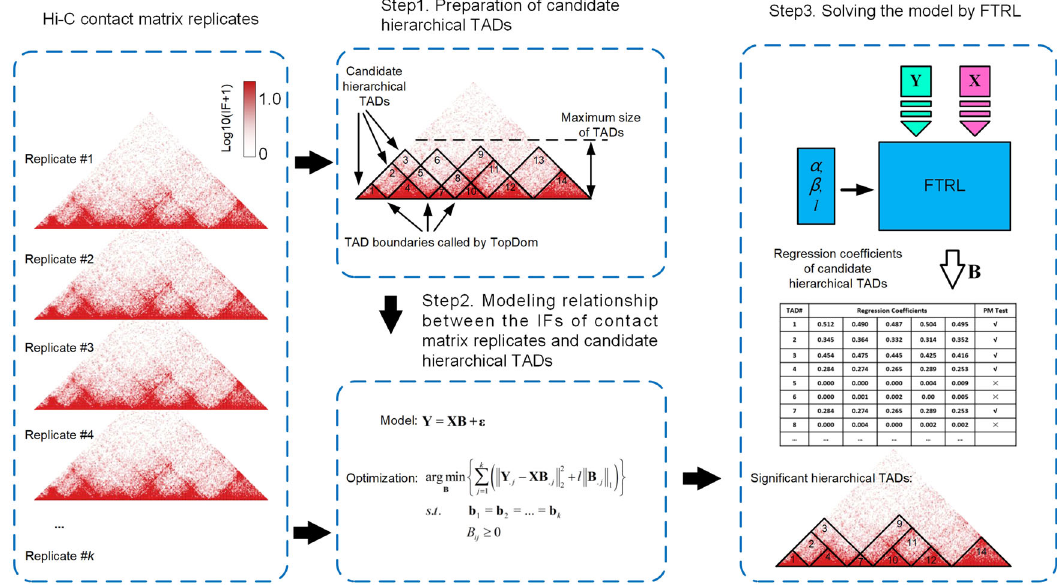
Fig. 1 Overview of TAD fi t. TAD fi t consists of three major steps. Step 1, a set of TAD boundaries on the diagonal of a pseudo contact matrix derived from input replicates is called by TopDom, and then assembled in all-possible pairs to prepare the candidate hierarchical TADs. For example, a total of 21 candidate hierarchical TADs can be obtained by assembling 7 TAD boundaries, and the number of these TADs can be optionally limited to 14 according to the threshold of TAD size given by user. Step 2, a multivariate linear regression model is proposed to fi t the IFs of Hi-C contact matrix replicates with the candidate hierarchical TADs, on the hypothesis that each IF in contact matrix re fl ects the cumulative effect of hierarchical TADs in which it is fallen. Step 3, the model is solved with the help of FTRL. The regression coef fi cients for these candidate hierarchical TADs are output, and a right-tailed permutation test is used to determine the signi fi cant ones, as shown above, 10 signi fi cant ones are screened out from 14 candidate